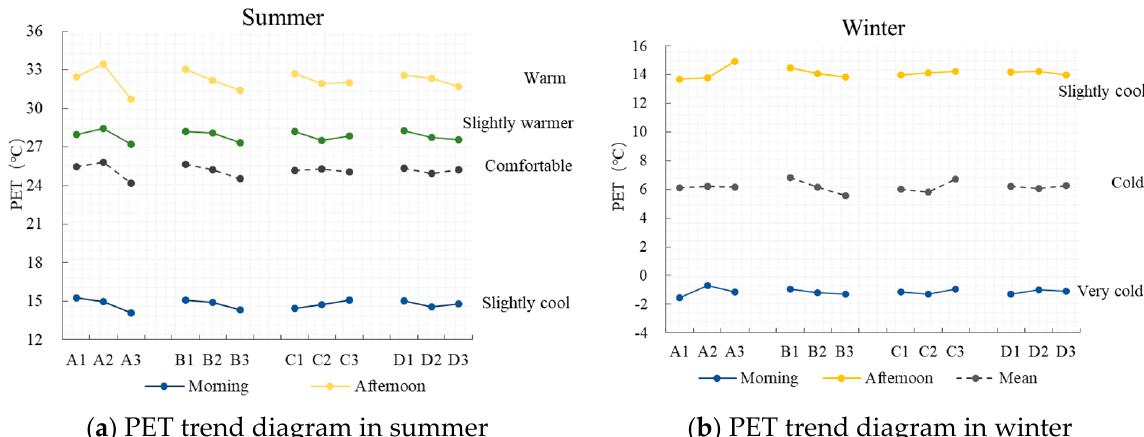
Figure 7. PET trend of outdoor public activities in residential areas in summer and winter. Table 8. Results of orthogonal test in summer and winter.